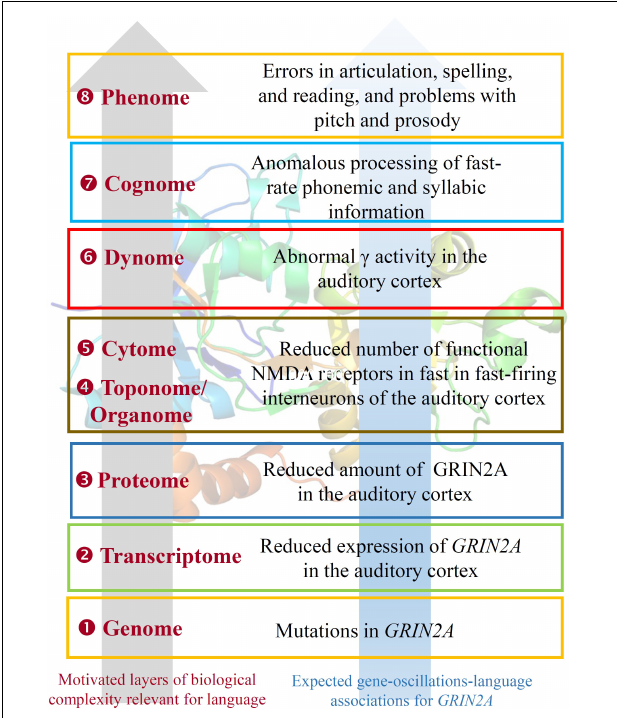
FIGURE 6 | GRIN2A as an example of the observed (and expected) bridging links across the different levels of the biological analysis of language. As highlighted in the text, mutations in the gene give rise to different forms of epilepsy-aphasias, like Landau–Kleffner syndrome, continuous spike and waves during slow-wave sleep syndrome, and rolandic epilepsies. GRIN2A expression is found in several brain areas; a noteworthy upregulation of the gene is observed during late embryonic development. GRIN2A encodes the subunit 2A of the NMDA receptor, which plays a key role in long-term potentiation, a physiological process important for memory and learning. This role seemingly results in part from its effect on γ oscillation formation and modulation. As also noted in the text, GRIN2A levels are reduced in fast-firing interneurons of people with schizophrenia. As also discussed, mutations in GRIN2A result in errors in articulation, and in problems with pitch and prosody, which pertain to linguistic prosody, and which can be tracked to the abnormal γ activity, which is crucial for the correct processing of fast-rate phonemic and syllabic information. The 3D structure of GRIN2A, inserted as the background of the picture, is from the RSCB Protein Data Bank (http://www.rcsb.org/pdb/home/home.do). Here, ‘genome’ refers to the set of genes related to brain rhythms that are relevant for language, ‘transcriptome,’ to their RNA products, and ‘proteome’ to the proteins they encode. ‘Toponome’ refers to the whole set of codes of proteins and other biomolecules found in the cells surface, whereas ‘Organome’ refers to the set of cell signaling molecules involved in cell and organ crosstalk. ‘Cytome’ refers to the collection of different cell types of the organism. ‘Connectome’ refers to the wiring of brain areas involved in language processing. ‘Dynome’ refers to the brain dynamics underlying (and supporting) this processing, in the line of Kopell et al. (2014) and Murphy (2015b). ‘Cognome’ refers to the basic cognitive operations underlying language (and in this case, speech processing), in the line of Poeppel (2012). Finally, ‘phenome’ refers to the discrete, language-specific activities (in this case, phonological and phonetic aspects of